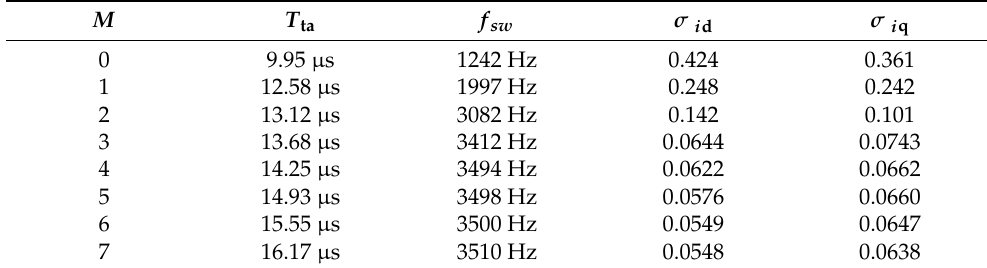
Table 3. The impact of M on